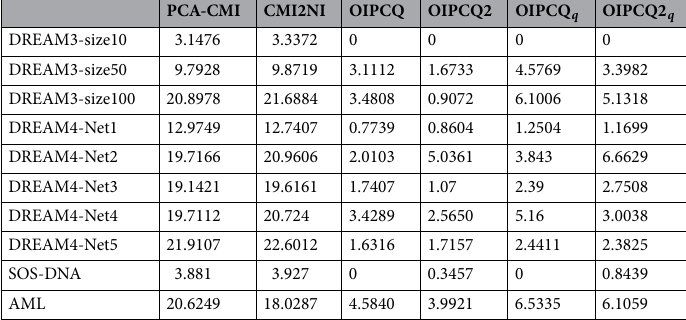
Table 6. Standard deviation for true positive based on different